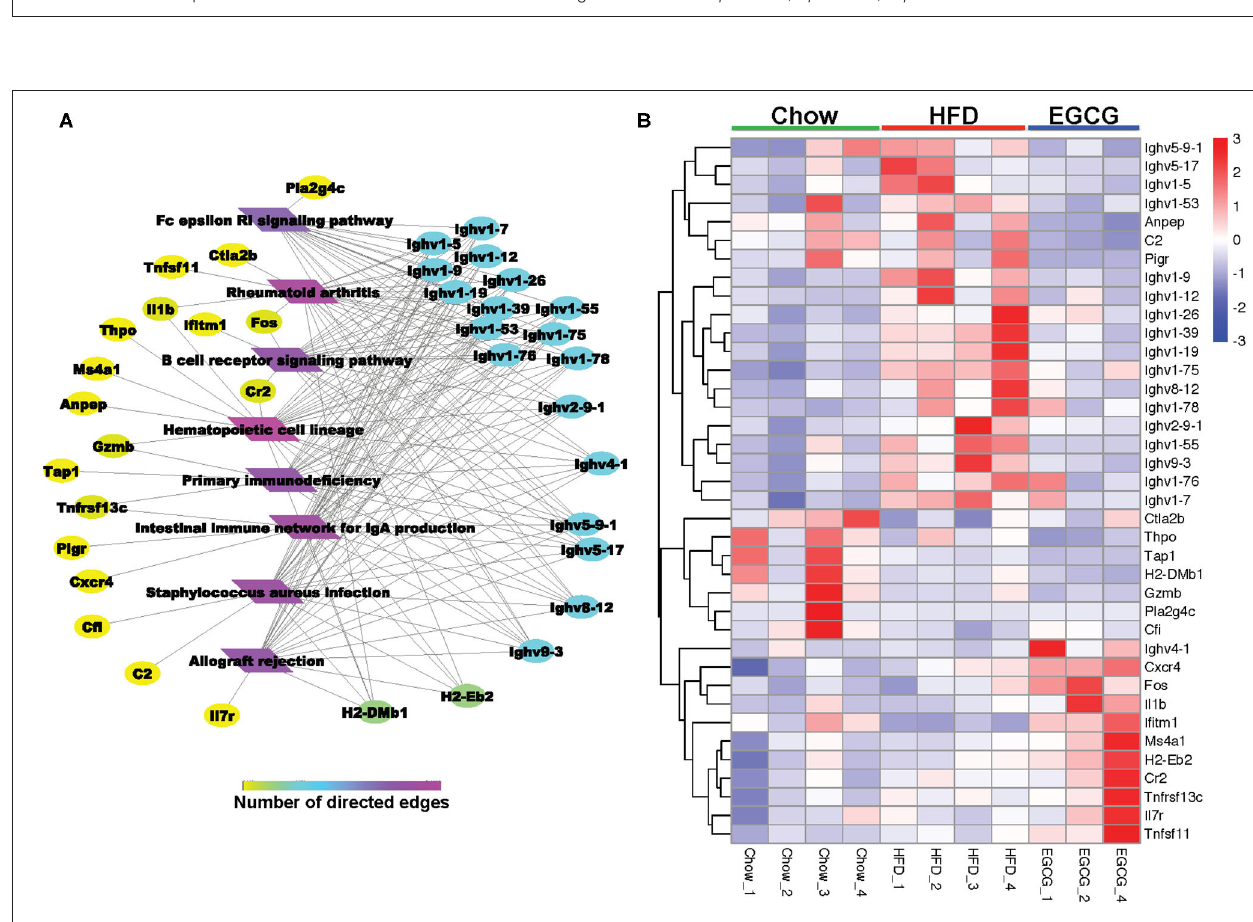
FIGURE 7 | EGCG Administration improved immune system in HFD mice. (A) Network analysis of DE genes involved in KEGG pathway related immune system. (B) Heatmap of DE genes involved in common KEGG pathway related immune system between two comparisons (HFD vs. Chow and EGCG vs. HFD).